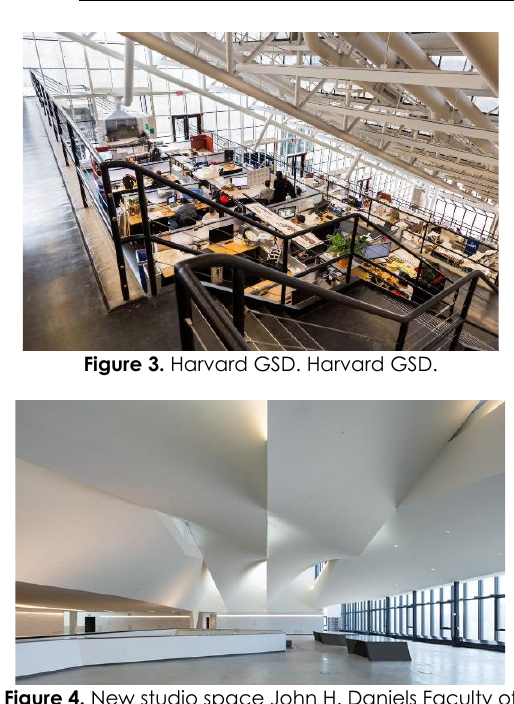
Figure 4. New studio space John H. Daniels Faculty of Architecture, Landscape and Design at the University of Toronto. One Spadina. Photo John Horner.